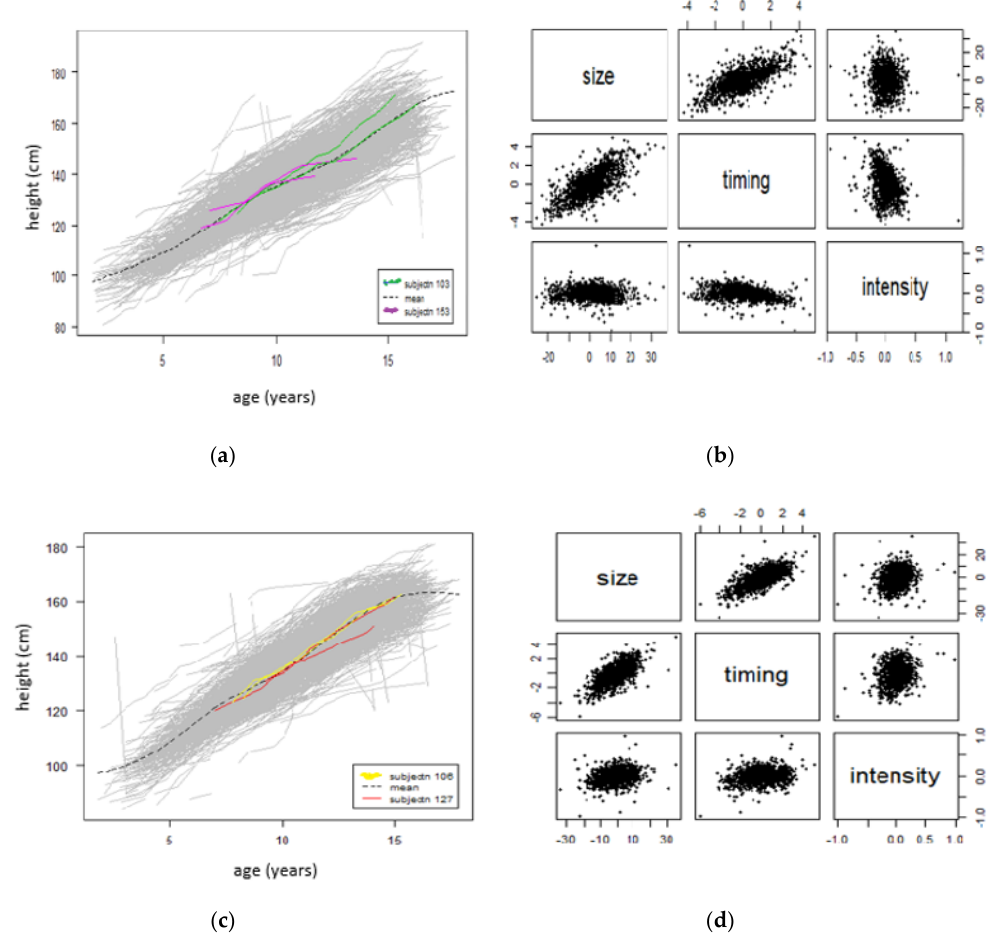
Figure 5. E ff ects of SITAR adjustment in individual curves for boys and girls (separately). E ff ects of